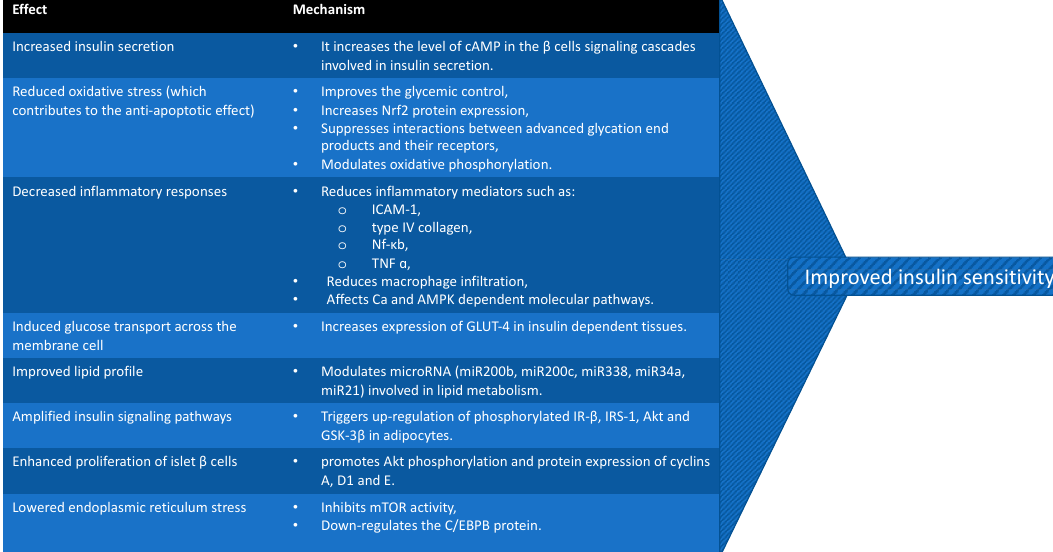
Figure 6. Possible mechanisms by which GLP-1RAs induce insulin sensitivity (cAMP = 3’,5’-cyclic adenosine monophosphate; Nrf2 = nuclear factor erythroid 2-related factor 2; ICAM-1 = Intercellular Adhesion Molecule 1; Nf- κ b = nuclear factor kappa b; TNF α = tumor necrosis factor alpha; AMPK = 5’ AMP-activated protein kinase; GLUT-4 = Glucose transporter type 4; mTOR = mammalian target of rapamycin; C/EBPB = a transcription factor).